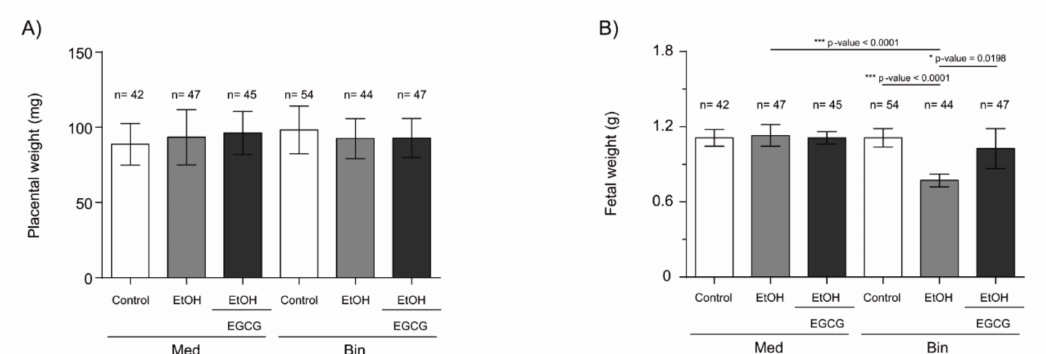
Figure 1. C57BL/6J mouse placental ( A ) and fetal ( B ) weight at gestational Day 19 under the various experimental conditions. Administered once a day: Binge (Bin) control: isocaloric maltodextrin solution (5.52 g/Kg/day); Bin EtOH: 20% ( v/v ) of ethanol solution in tap water (3 g/Kg/day); Bin + EGCG EtOH: ethanol 3 g/Kg/day + EGCG 30 mg/Kg/day. Administered twice a day: Med control, Med: isocaloric maltodextrin solution (1.38 g/Kg/day); Med EtOH: 10% ( v/v ) of ethanol solution (0.75 g/Kg); Med + EGCG EtOH: ethanol 0.75 g/Kg + EGCG 30 mg/Kg. For intergroup comparisons, the Kruskal–Wallis test was used. Asterisks denote the level of significance: * p -value < 0.05, *** p -value <